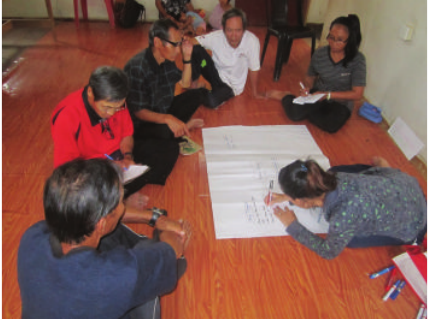
Figure 3: Discussion within community